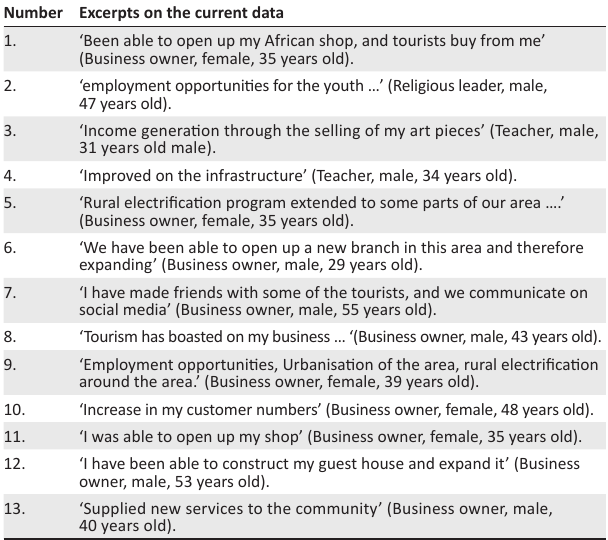
TABLE 2: Excerpts from study participants: Benefits of mountain gorilla